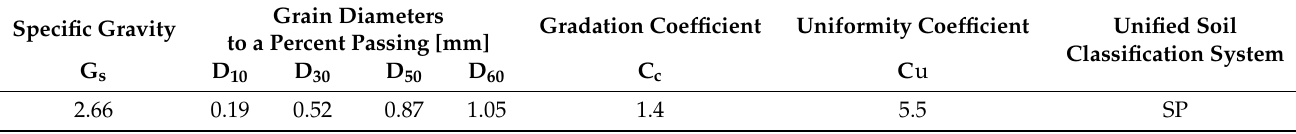
Table 1. Index properties of the soil used in this